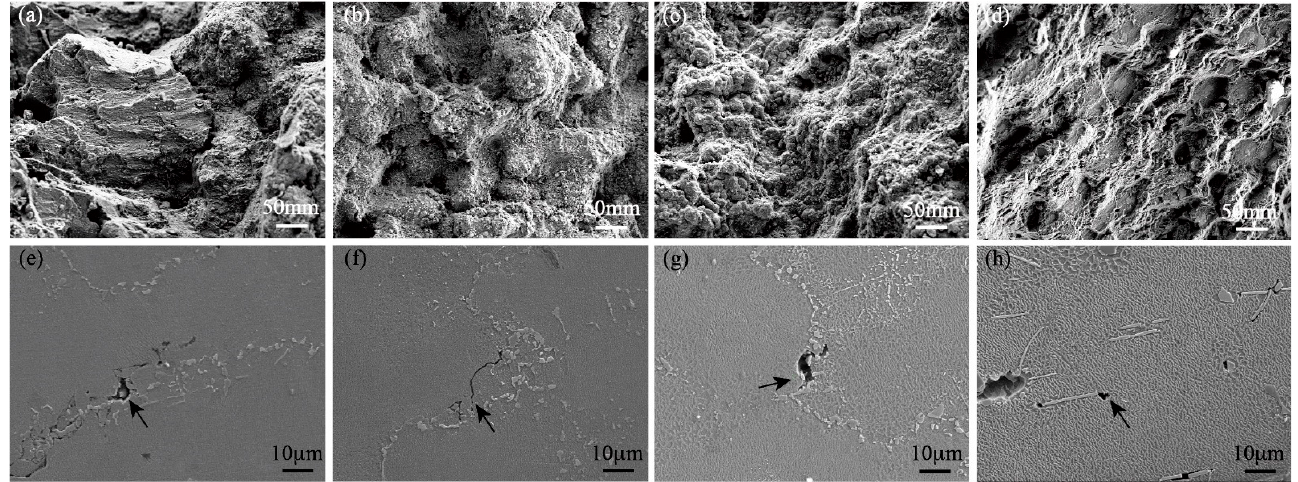
Figure 10. SEM images of fracture surfaces and the longitudinal microstructures after stress rupture testing at 975 °C/225 MPa: ( a , e )Alloy I, ( b , f ) Alloy II, ( c , g ) Alloy III, ( d , h ) Alloy IV.